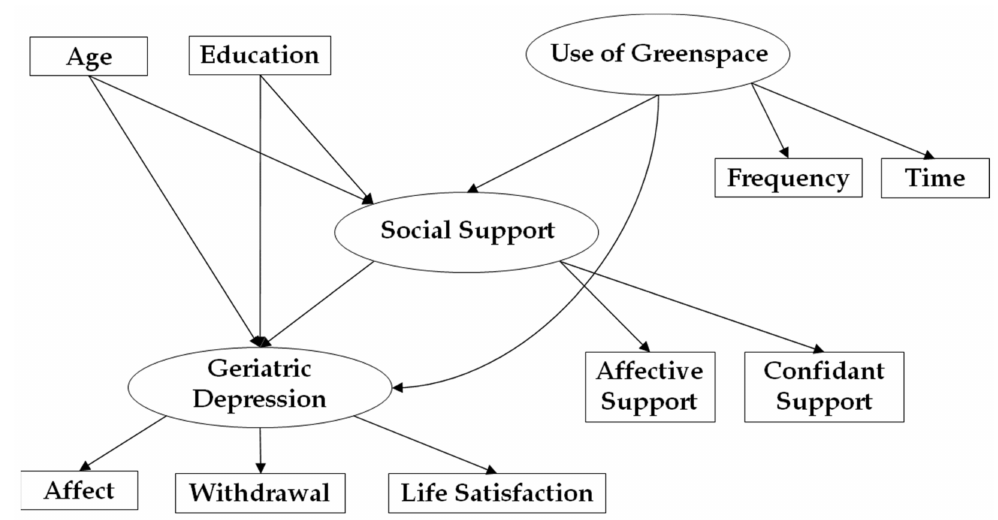
Figure 1. Proposed theoretical model.